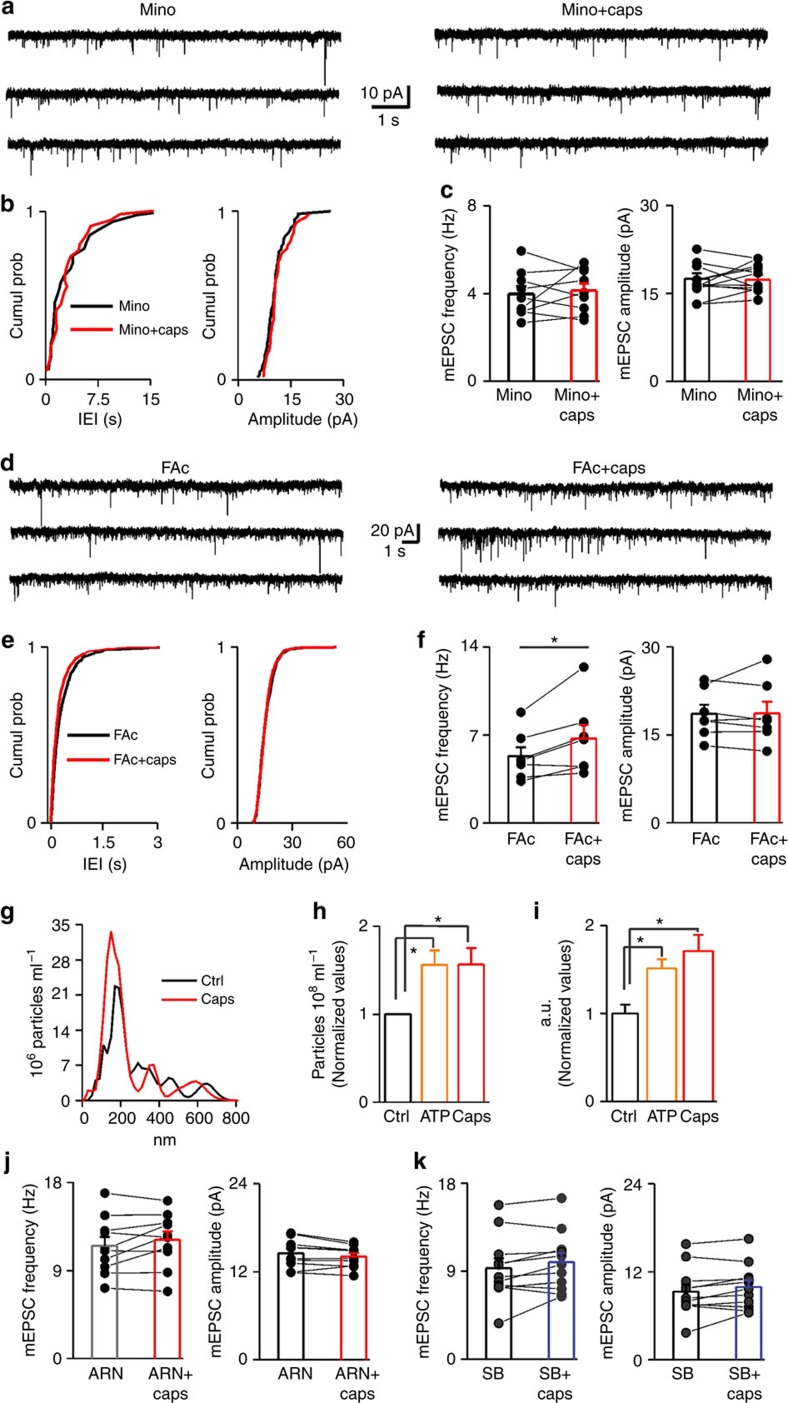
TRPV1 is functionally expressed in cortical microglia and modulates synaptic transmission by microvesicles shedding.(a) Example recording of mEPSCs before (left) and during (right) capsaicin in the presence of minocycline. (b) Cumulative probability plots comparing minocycline (black line) and minocycline plus capsaicin (red line) on mEPSC IEI and amplitude of the recording showed above (P=0.25 and P=0.31, KS test). (c) Bar histograms of group data showing the lack of capsaicin-mediated increase of mEPSC rate when microglia activation is blocked by minocycline (from 3.98±0.35 to 4.13±0.33 Hz, n=9, P=0.53; from 17.54±0.94 to 17.34±0.79 pA, n=9, P=0.70, Paired Sample t-Test). Group data are presented as single value and mean±s.e.m. (d) Example recording of mEPSCs before (left) and during (right) capsaicin in the presence of 1 mM FAc. (e) Cumulative probability plots comparing FAc (black line) and minocycline plus capsaicin (red line) on mEPSC IEI and amplitude of the recording showed above (P<0.01 and P=0.28, KS test). (f) Summary data of both mEPSC frequency and amplitude recorded in the presence of FAc before and during capsaicin application (FAc 5.30±0.72 Hz, FAc+caps 6.70±1.10 Hz, *P<0.05 Paired t-test; FAc 18.58±1.55 pA, FAc+caps 18.63±1.98 pA, n=7, P=0.89 Paired Sample t-Test). (g) Representative size profile of EVs released constitutively (black line) or upon capsaicin challenge (red line) from 5 × 105 murine microglia in 500 μl of serum free medium during a period of 10 min. (h) Histogram showing the fold increase of total EV concentration detected by Nanosight upon stimulation with ATP or capsaicin (Kruskal-Wallis test, P=0,035). (i) Histogram showing the fold increase of MVs shed selectively from the plasma membrane and measured by a spectrophotometric assay under the same stimuli (Holm-Sidak's, P<0,05). (j) Group data showing that addition of ARN14988 reduces capsaicin-mediated increase of mEPSC frequency in cortical slices (from 11.51±0.92 to 12.12±0.88 Hz, P=0.15; from 14.52±0.61 to 14.10±0.46 pA, P=0.06, Paired Sample t-Test, n=10). (k) Summary graph of mEPSC frequency (left) and amplitude (right) in the presence of 2 μM SB203580 before (black bar) and after capsaicin (blue bar) (from 9.30±1.00 to 9.93±0.90 Hz, P=0.08; from 10.67±0.47 to 10.75±0.49 pA, n=11, and P=0.89, Paired Sample t-Test and Wilcoxon Signed Rank Test, respectively). Data are values from single cells and/or mean±s.e.m. *P<0.05.